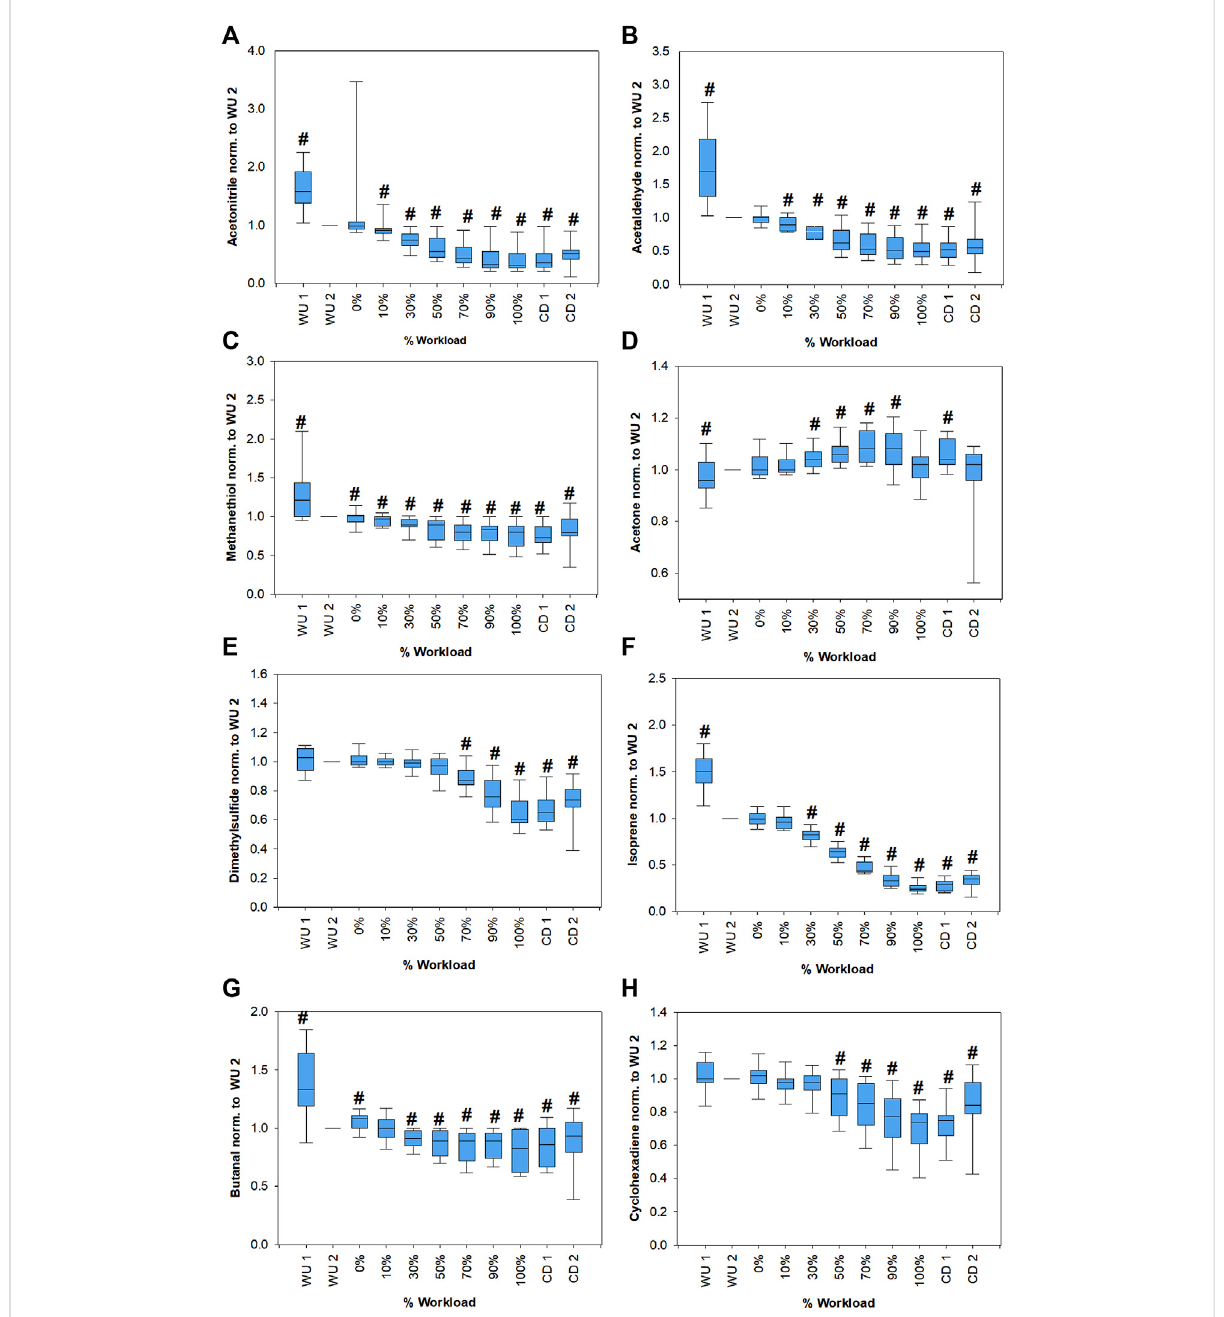
FIGURE 3 Changes of acetonitrile (A) , acetaldehyde (B) , methanethiol (C) , acetone (D) , dimethylsul fi de (E) , isoprene (F) , butanal (G) and cyclohexadiene (H) concentrations from all volunteers as a function of the relative workload. Absolute concentrations of all compounds were normalized to respective values at the last minute of warm-up (WU 2) for emphasis of relative changes. Statistically signi fi cant changes (Friedman repeated measures ANOVA on ranks, Student-Newman-Keuls post-hoc test, p < 0.05) compared to WU 2 are marked with a hash. Corresponding p -values are shown in Supplementary Table